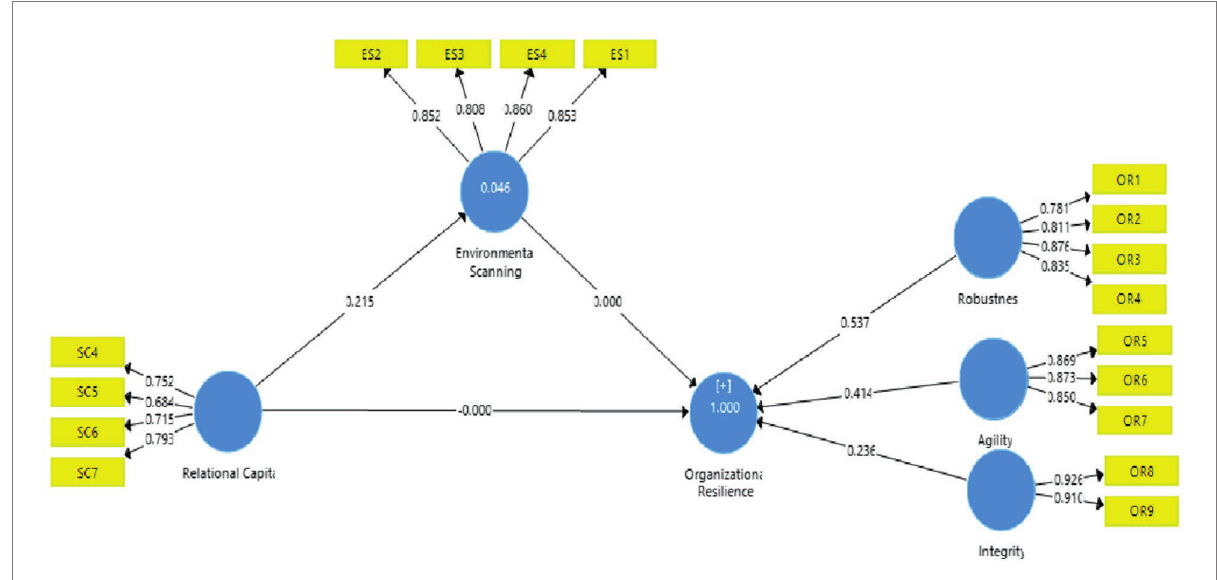
FIGURE 2 Factor loadings of individual